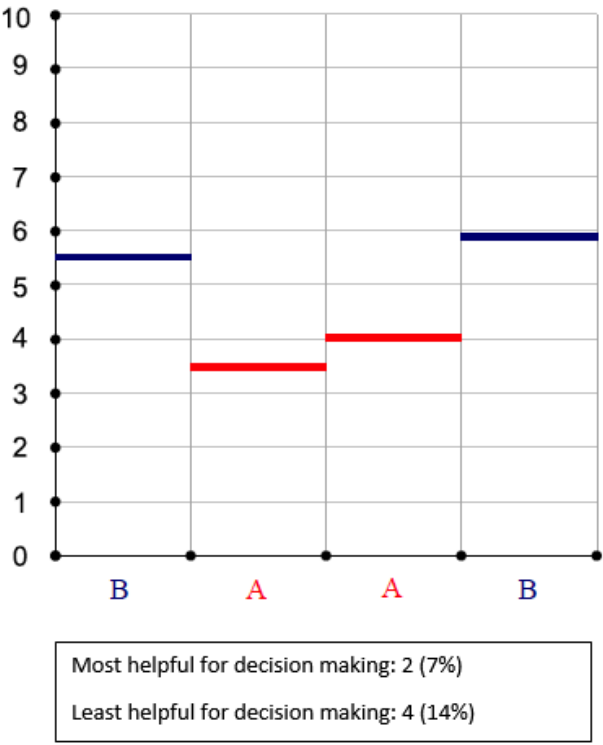
Figure 4. Pain intensity average (zero is no pain).